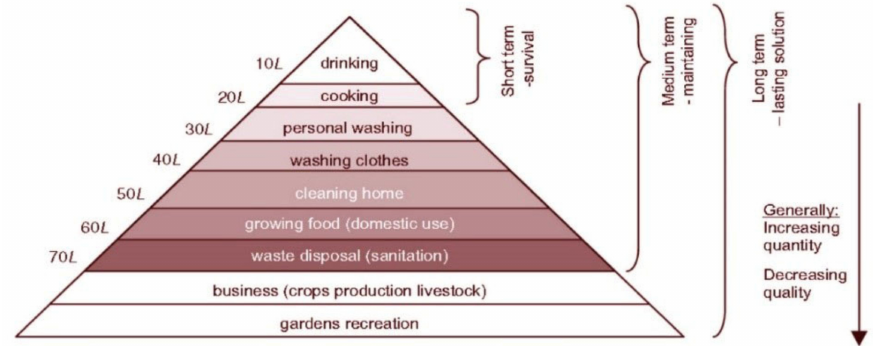
Figure 3. Short, medium and long term levels modified from